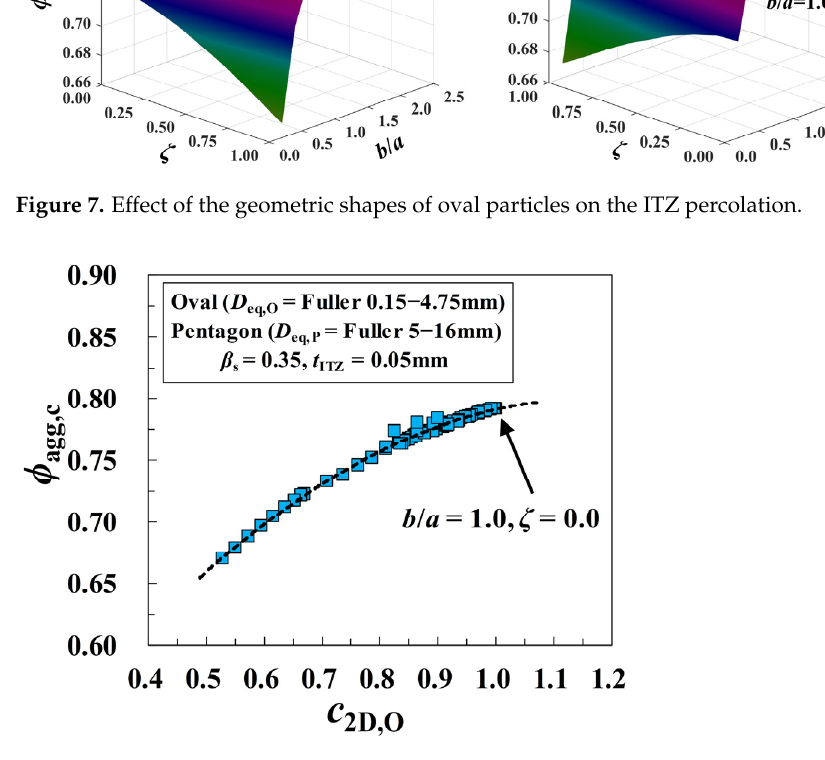
Figure 9. Effect of the geometric shapes of polygonal particles on the ITZ percolation.